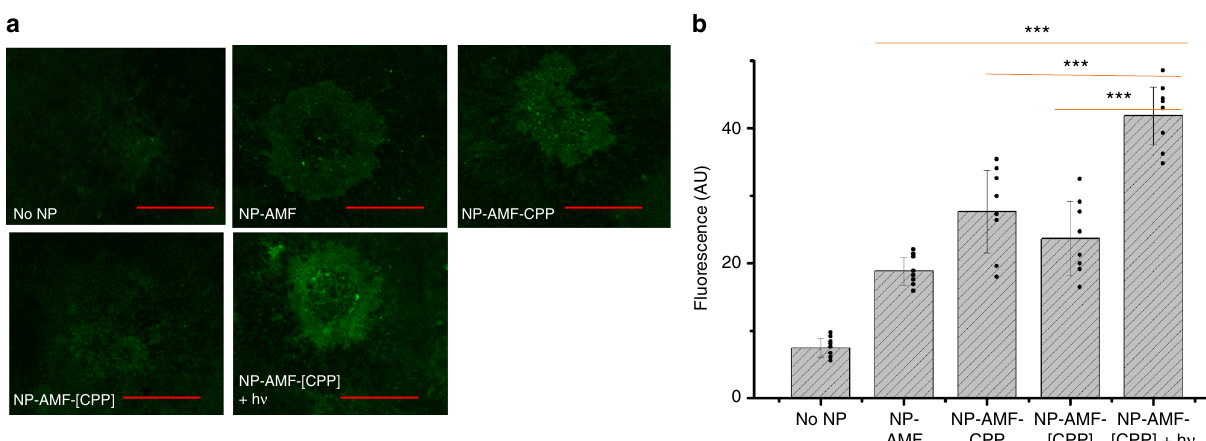
Fig. 4 Light-triggered targeting of CNV in vivo. a Representative (of 8) fl uorescent images of fl at-mounted choroid 24 h after injection with NPs. The scale bar is 100 μ m. b Quanti fi cation of the intensity of fl uorescent neovessels from images in a , normalized by the lesion size. Data are means ± SD ( n = 8 lesions) *** P < 0.001 (unpaired t -test)